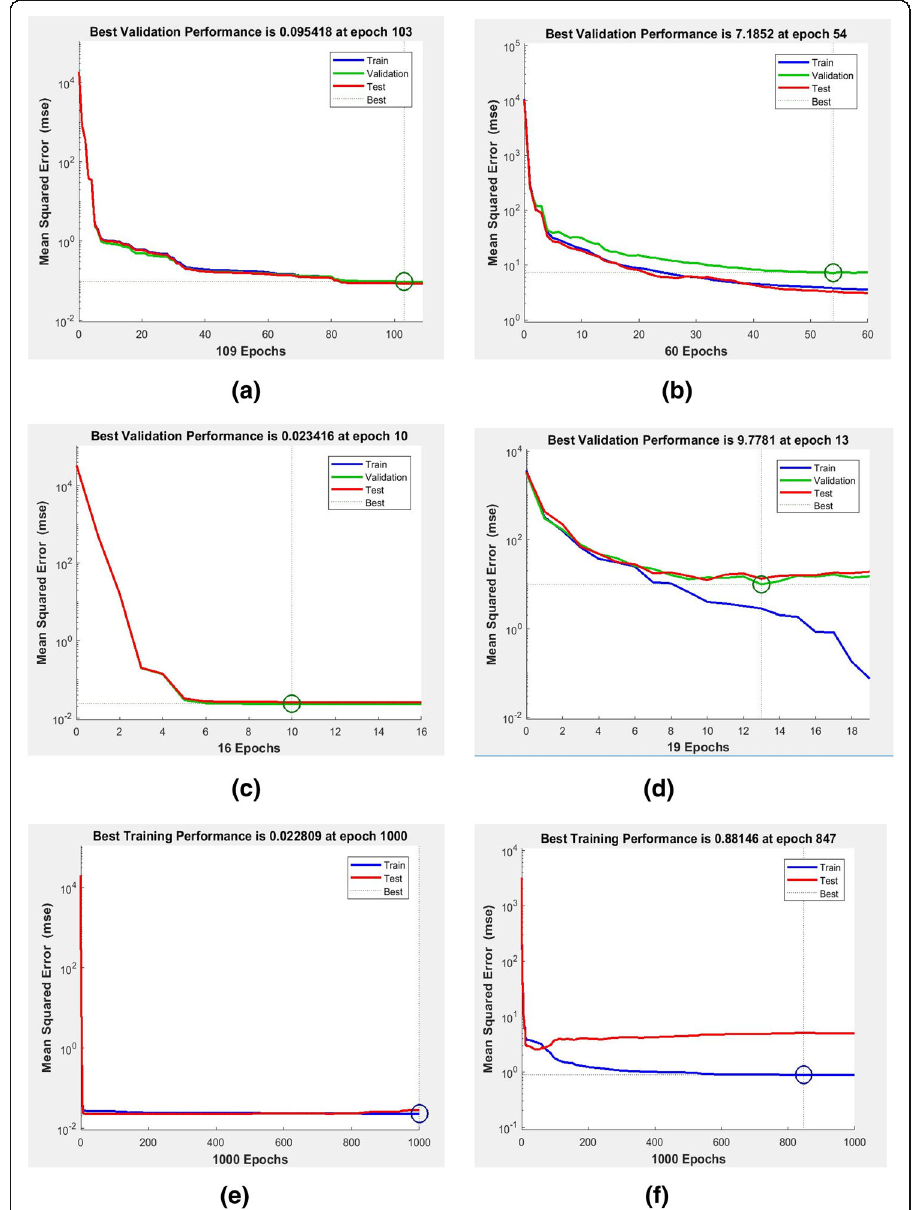
Regularization on 15-min